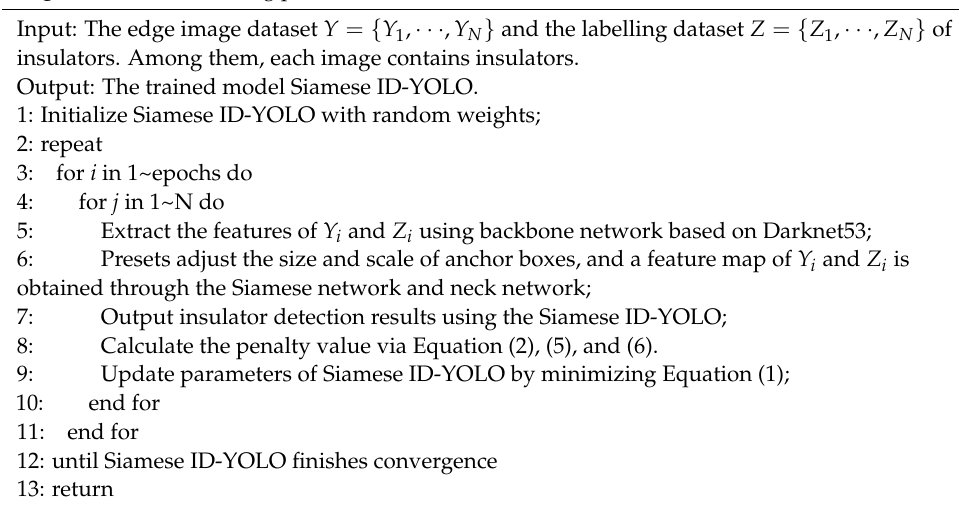
Algorithm 1. The training process of Siamese